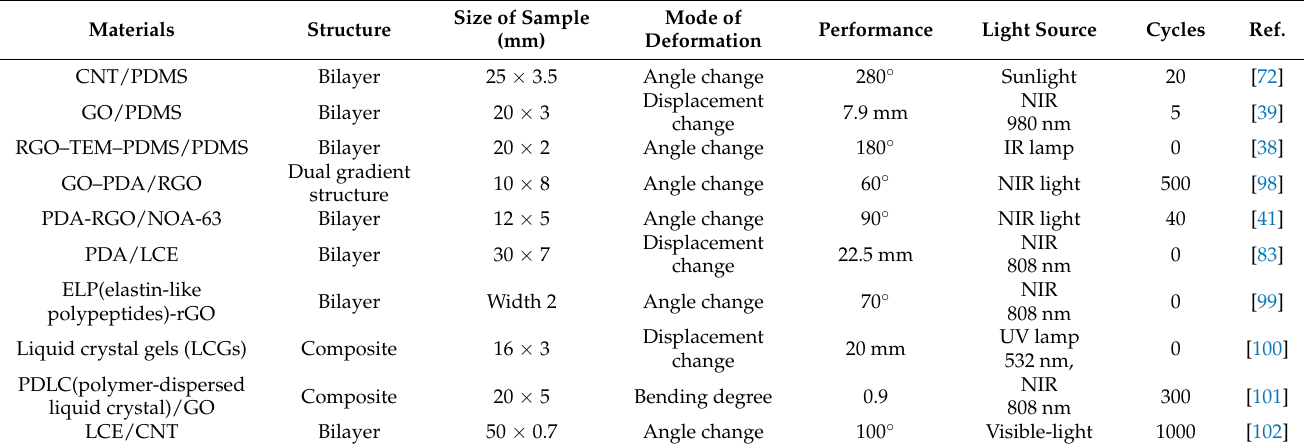
Table 2. Various light-responsive actuators and their